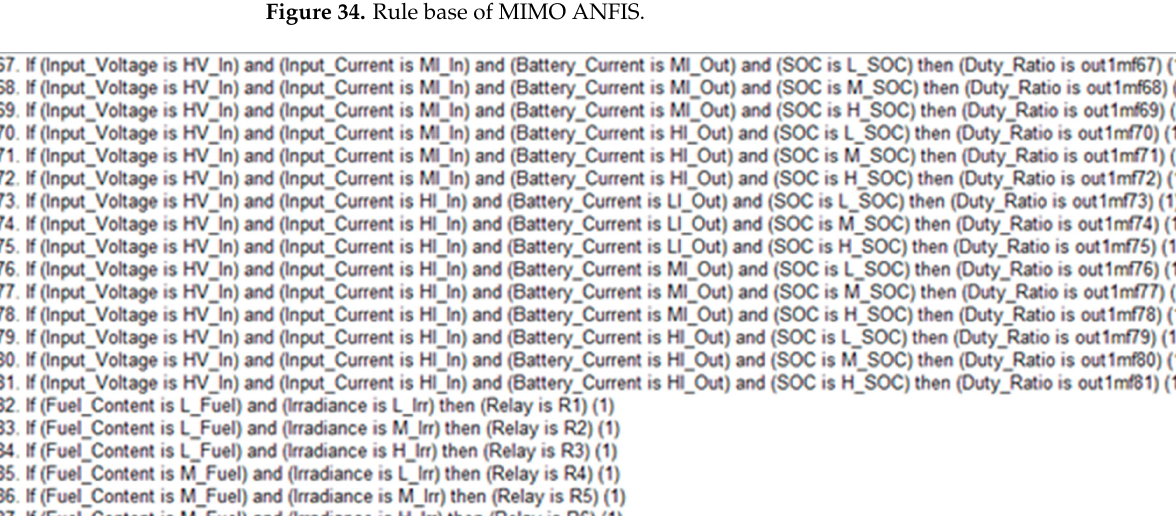
Figure 34. Rule base of MIMO ANFIS.